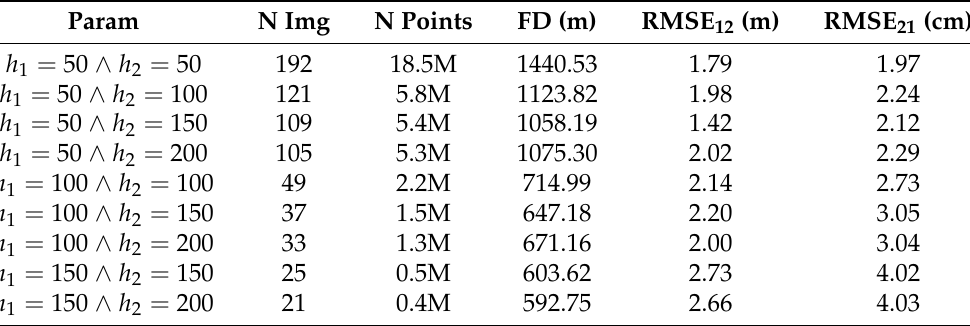
Table 5. Quality metrics for different altitudes for simple and double grid options with a frontal and lateral overlap of 90% and 80%,